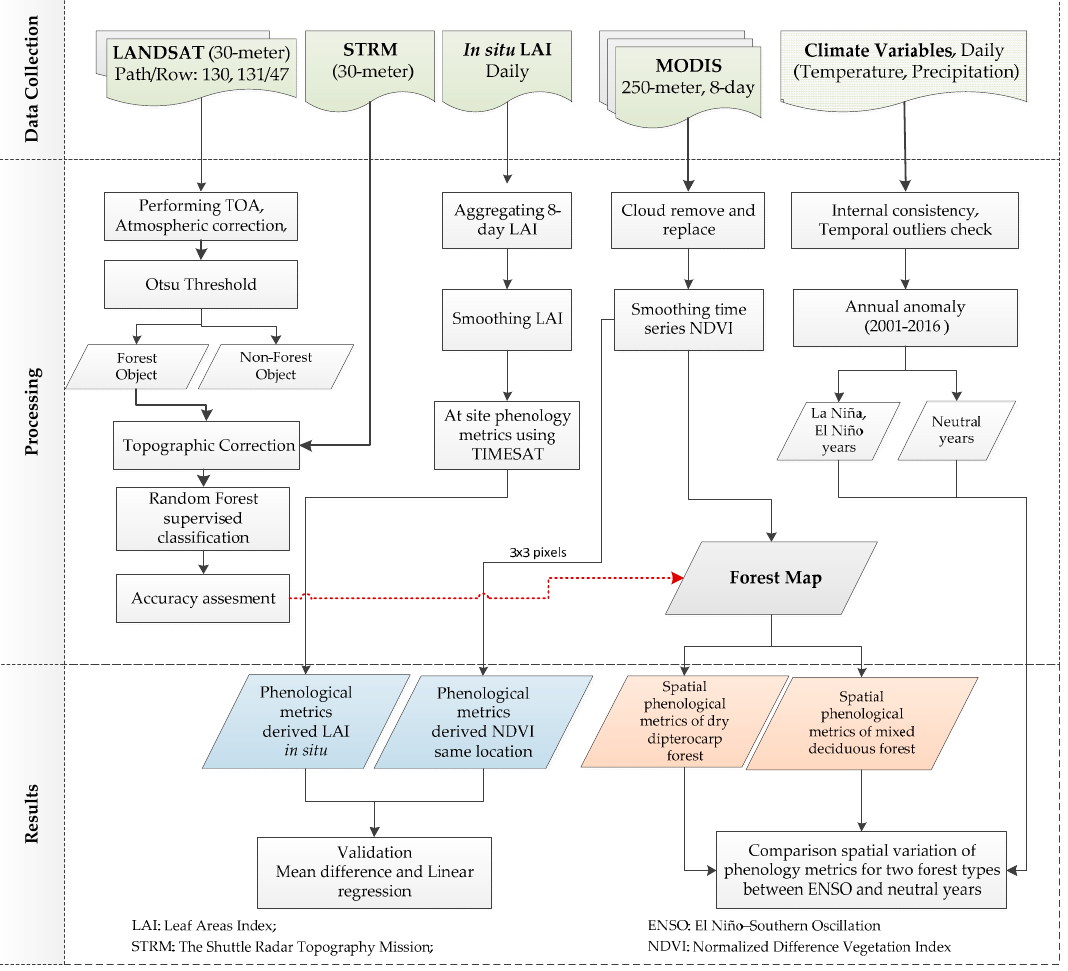
Figure 2. The flowchart of methodology in this study.